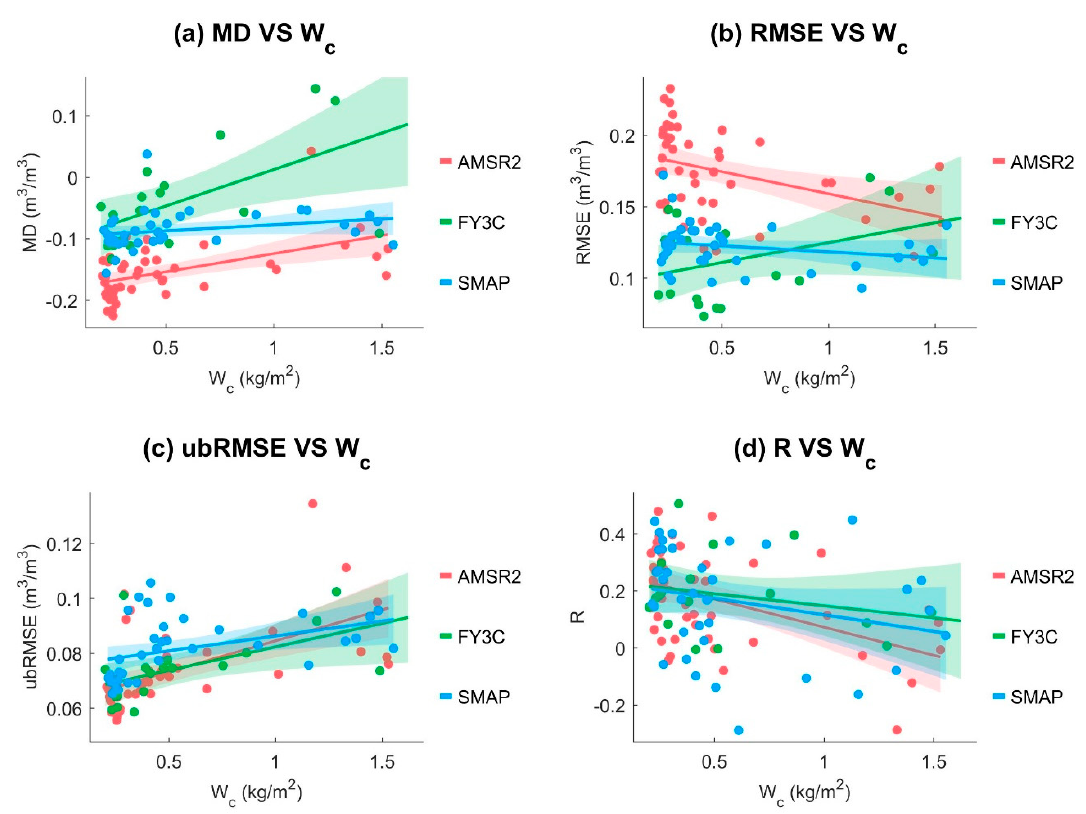
Figure 13. The spatial evaluation results (MD, RMSE, ubRMSE, and R) versus VWC at different times in the year. VWC was estimated from the MODIS NDVI data using the empirical relationship; refer to Equations (1) and (2). Only the 46 dates when there existed NDVI data were used.